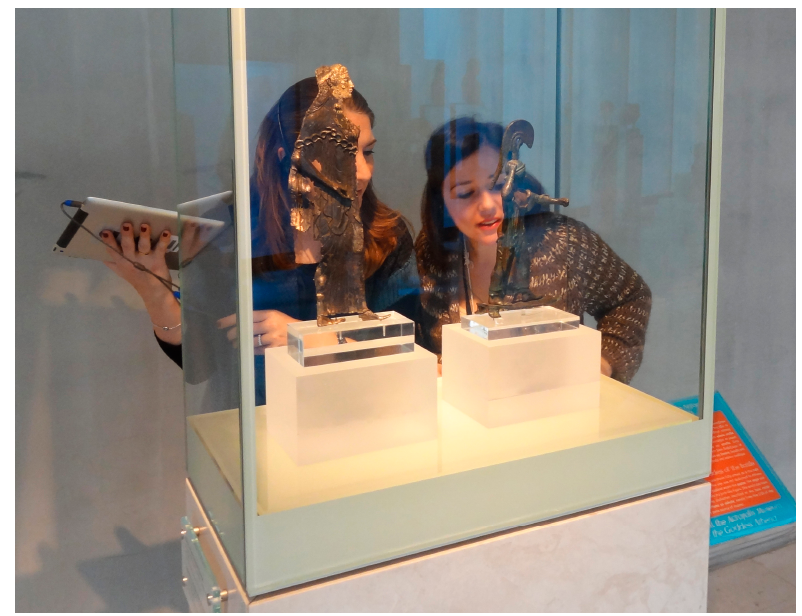
Figure A2. Visitors experiencing “Melesso’s story” witness, at the culmination of the story, the character’s name inscribed on a real artefact of 2500 years ago.